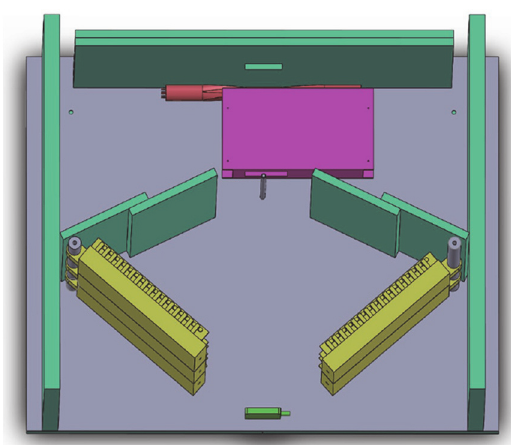
Fig. 3. Schematic of the LANSCE-in-a-box multi-modal portable neutron instrument. The dimensions of the square base- plate are ~1 m. From bottom to top, the detectors are a fission chamber (green), 96 3 He tubes on three panels (yellow), a light- box for scintillator-based imaging with a CMOS camera (magenta), and a dual-photomultiplier neutron transmission detector viewing a 6 Li glass scintillator. The sample is along the centreline of the instrument in front of the imaging lightbox. The green walls are borated polyethylene.